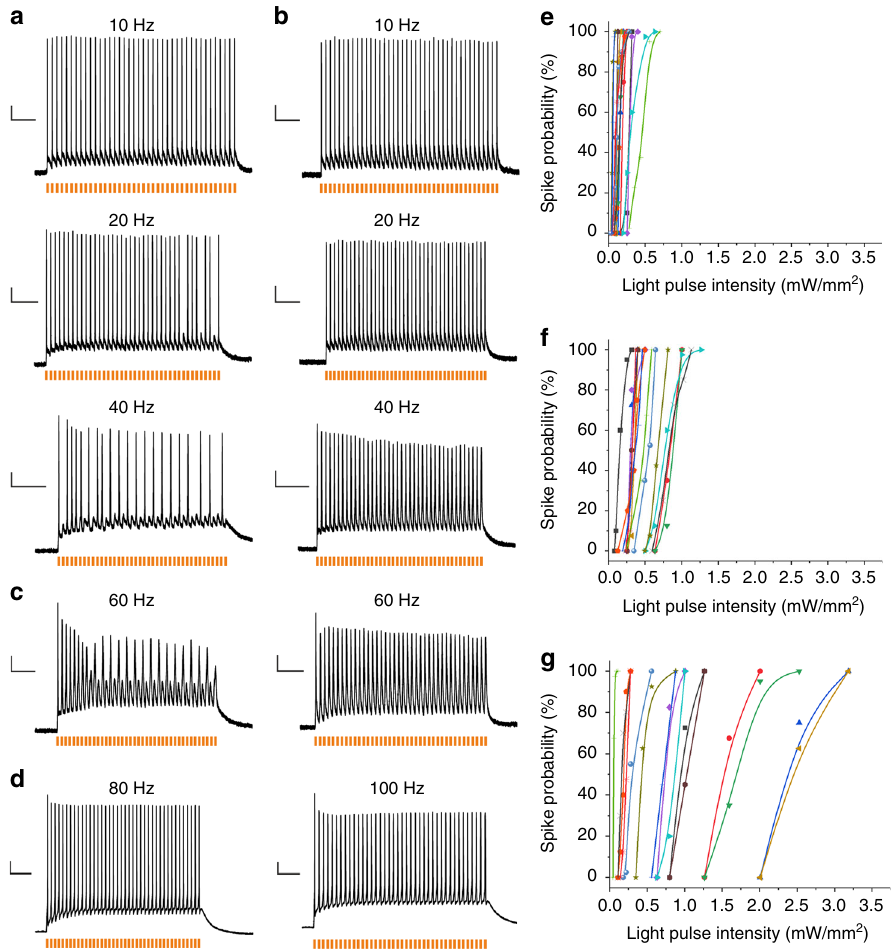
Fig. 2 Light-induced spiking in rat hippocampal neurons. a – d Spiking traces at different light-pulse frequencies. Rat hippocampal neurons heterologously expressing Chrimson-EYFP ( a ), Chrimson-EYFP K176R/Y261F/S267M (vf-Chrimson-EYFP) ( b ) and Chrimson-EYFP Y261F/S267M (f-Chrimson-EYFP) ( c , d ) were investigated by whole cell patch-clamp experiments under current-clamp conditions ( λ = 594 nm, pulse width = 3 ms, saturating intensity